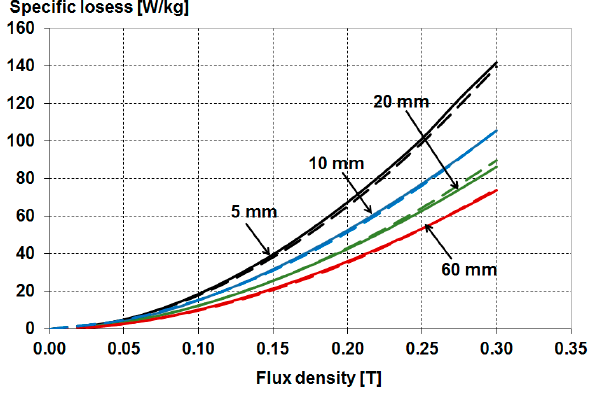
Figure 25. Measured and approximated loss characteristics of the M 270-35A sheet for various widths of the sheet samples at the frequency of 2000 Hz ( a ) and 3000 Hz ( b ) (measured—solid line, estimated—dashed line).